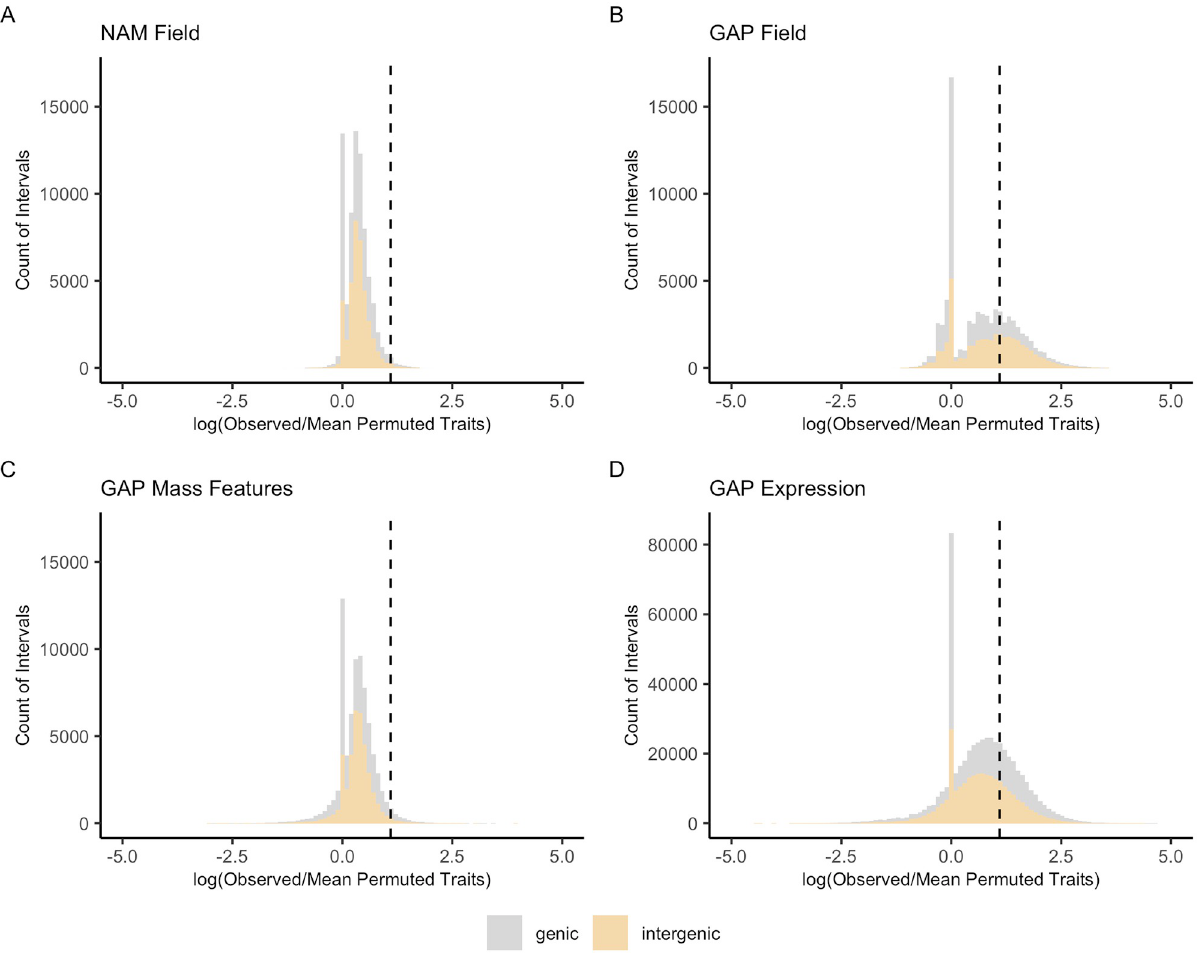
Fig 2. Distribution of QTL by interval. Of the intervals showing a five-fold higher proportion of pleiotropy over their permutations (right of the vertical dashed line), intergenic ranges tend to exhibit higher pleiotropy than genic ranges. Each value along the x-axis was calculated from the natural log of the number of observed traits mapping to each interval divided by the mean count of traits in the permuted data with a pseudo-count of plus one in the numerator and denominator. Values left of the vertical dashed line indicate higher pleiotropy in the permuted data versus the observed data suggesting the prevalence of high noise or no trait-SNP associations in either the observed or permuted data (peak at zero). Distributions are split into genic (gray) and intergenic (yellow) intervals for (a) NAM field, (b) GAP field, (c) GAP mass features, and (d) GAP expression traits.